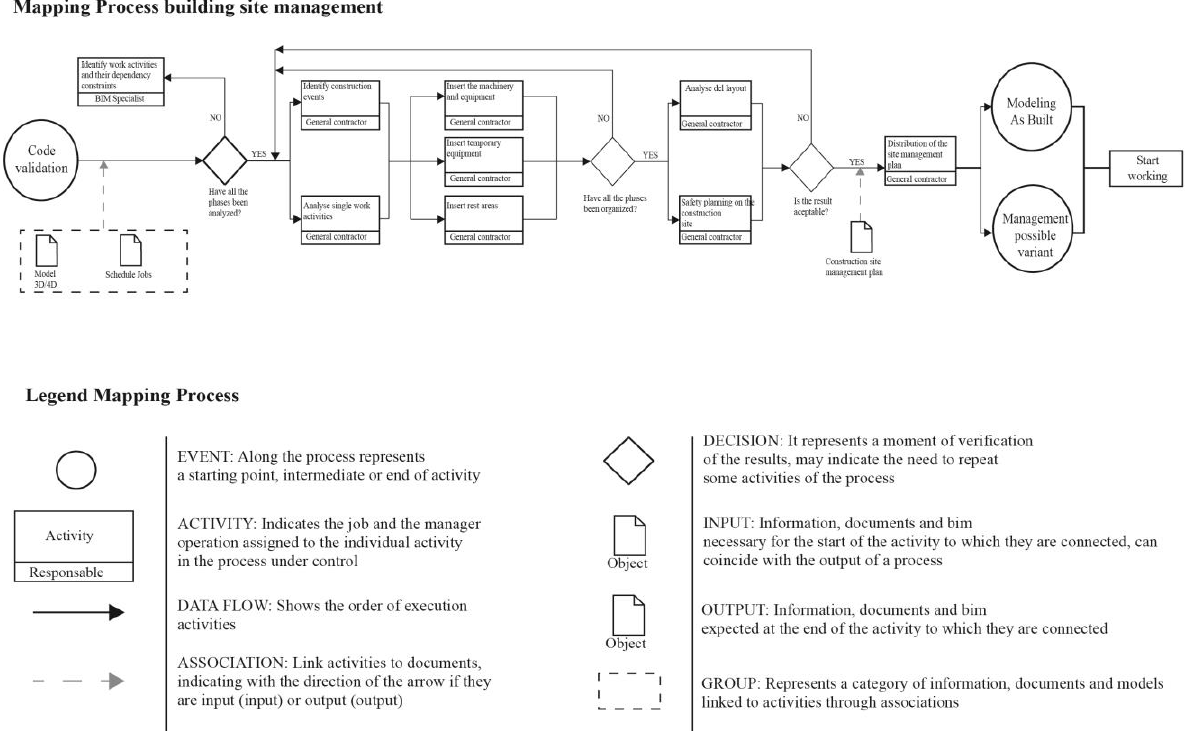
Figure 3: Example of mapping process used in